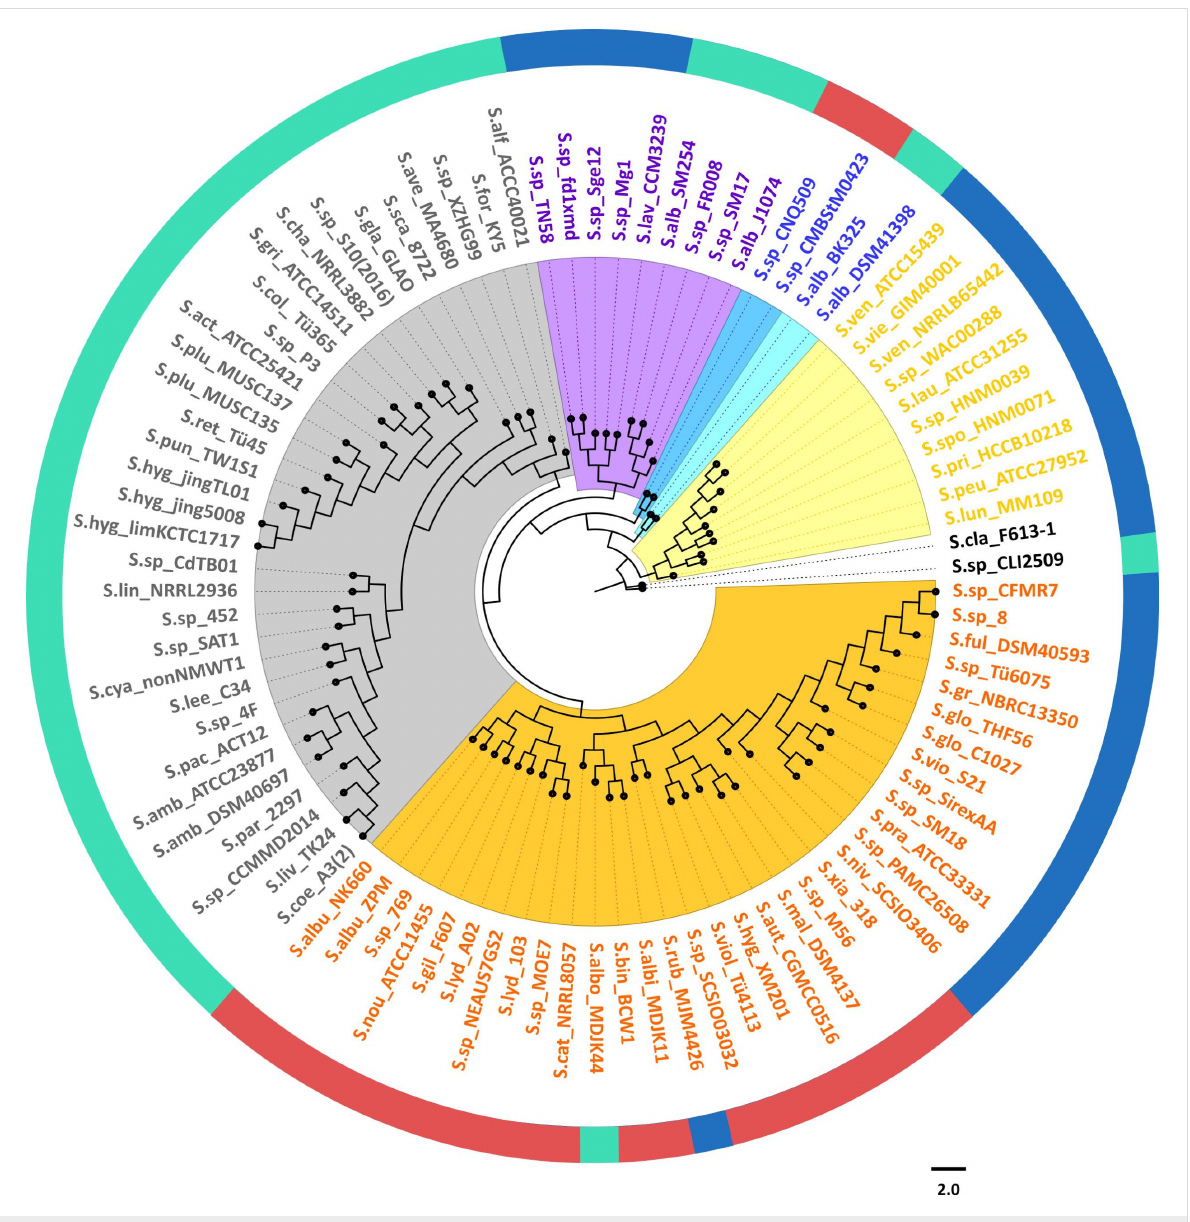
Figure 3: Phylogenetic tree of geosmin synthases. Unrooted maximum likelihood phylogenetic tree of 92 geosmin synthases from the Streptomyces species present in the phylogenetic tree in Figure 1. The colours in the outer ring correspond to the colours of the three main phylogenomic groups in the whole-genome species tree and indicate to which phylogenomic group each species belongs. The GenBank accession numbers of the geosmin synthases are listed in Table S3 (Supporting Information File 1).